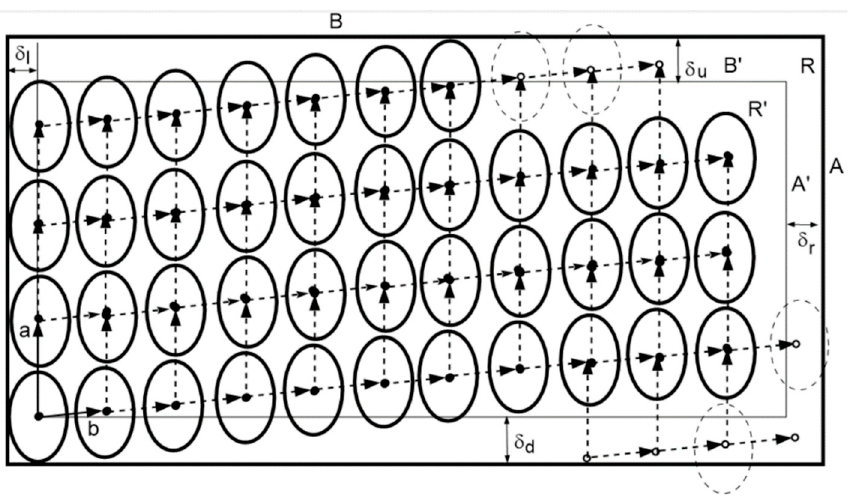
Figure 7. An example of a lattice.